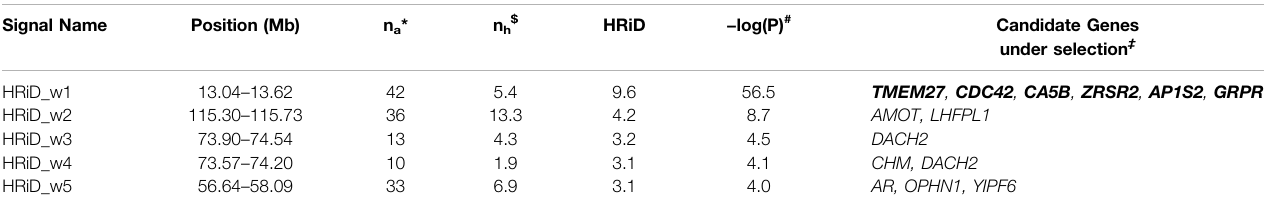
TABLE 2 | Description of mapping statistics and annotation of genes in selection signals on the X-chromosome in East Adriatic sheep by new HRiD